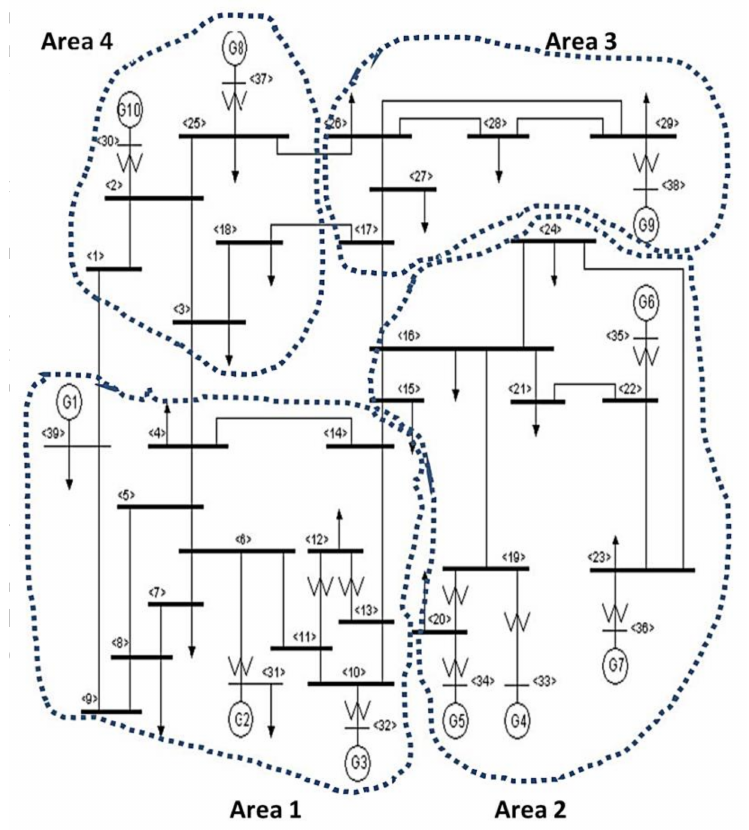
Figure 3. The decoupled New England 39-bus